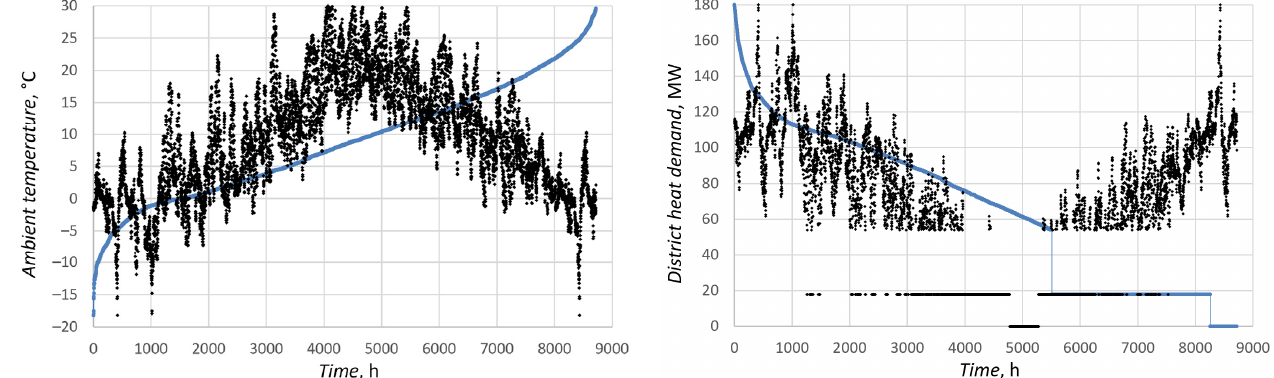
Figure 3. Ordered (blue color) and real (black color) diagrams of ambient temperature ( left side) and ordered (blue) and real (black) diagram of heat demand for the district heating system ( right side).